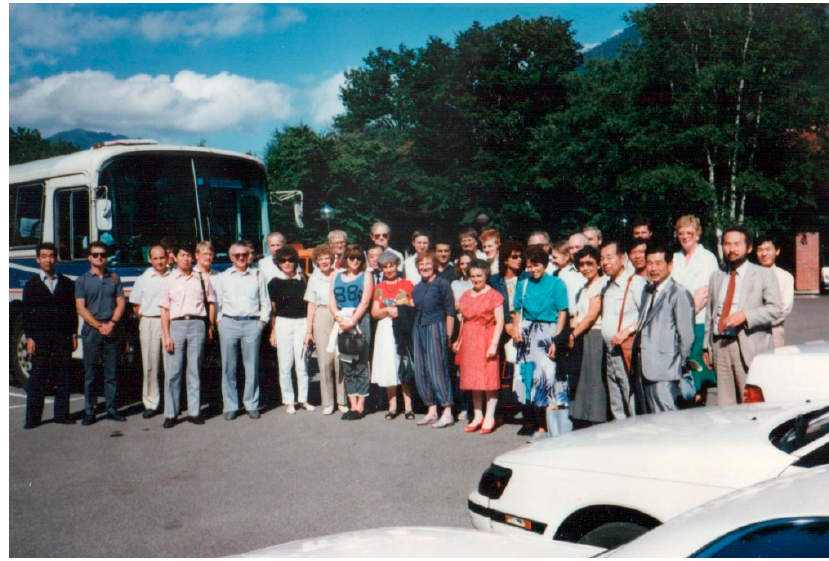
Figure 1. International Symposium on Separation Process Engineering, Tokyo, Japan, 26–27 September 1986.